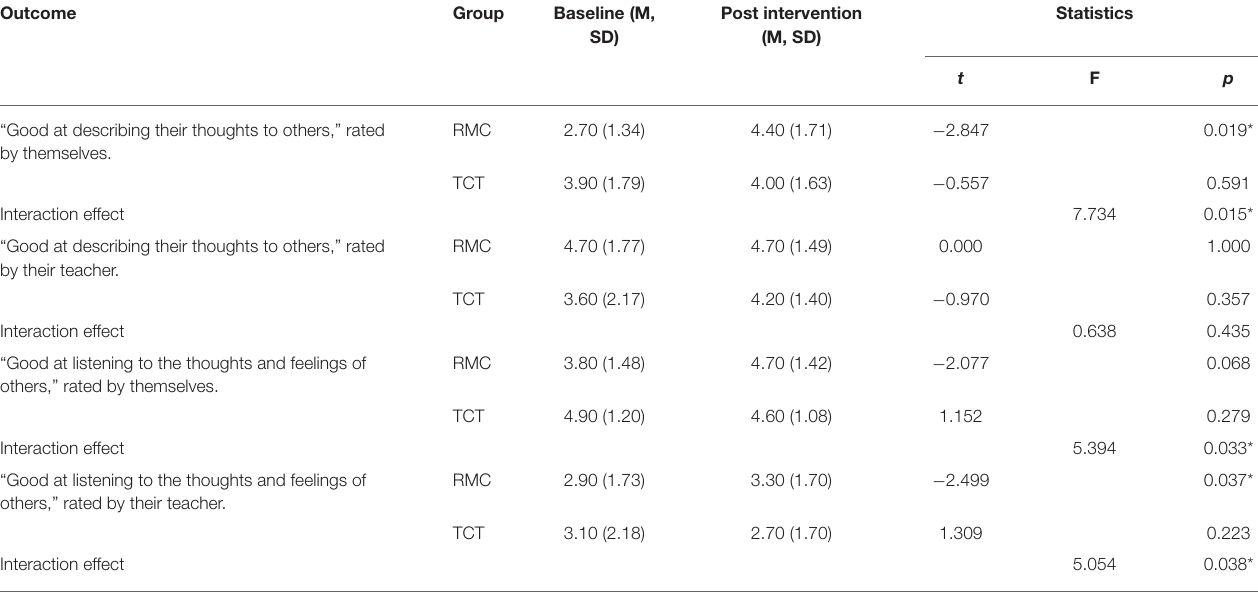
Post intervention SD) (M, SD) t F p